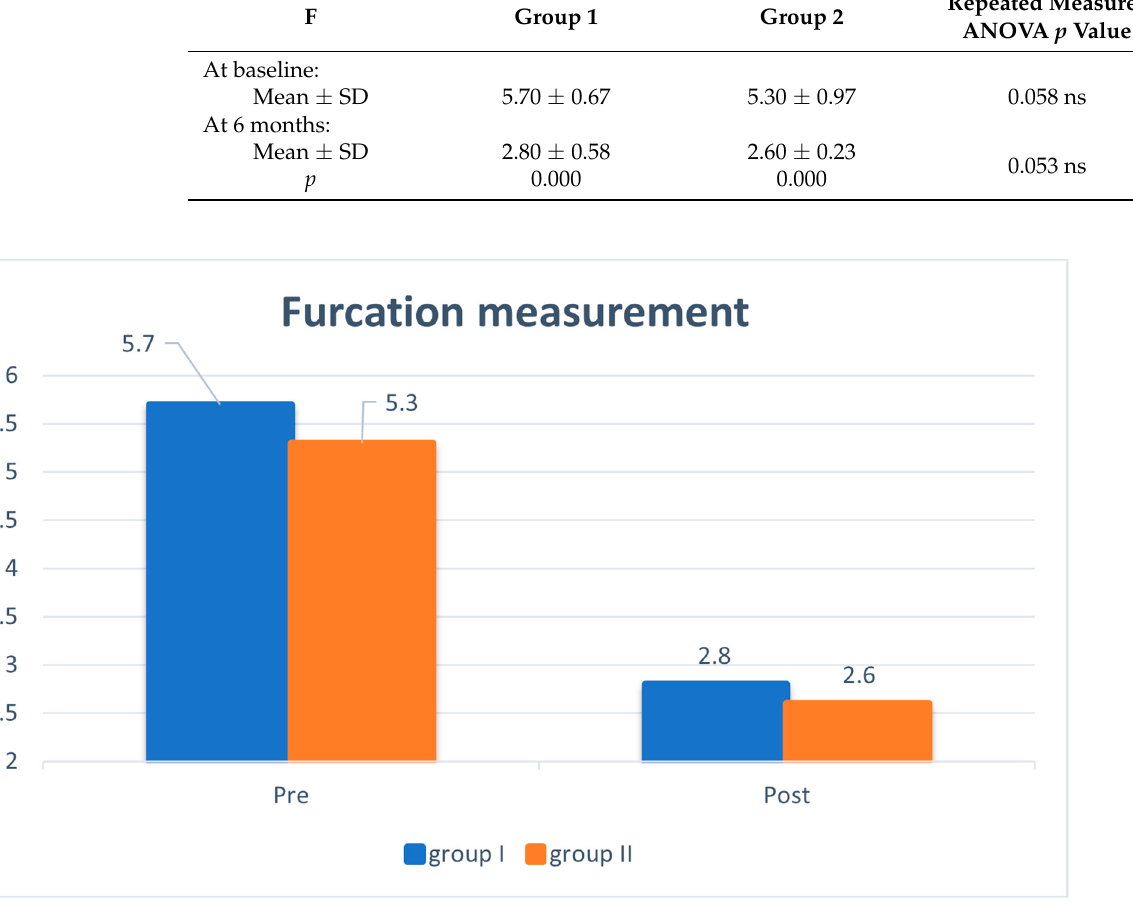
Figure 3. The mean furcation assessment values for groups 1 and 2 at baseline and at 6 months postoperative.